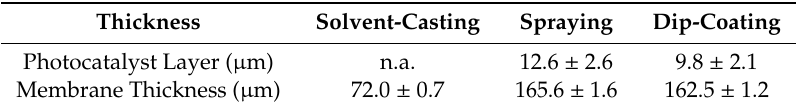
Table 1. Photocatalyst layer and membrane thickness.